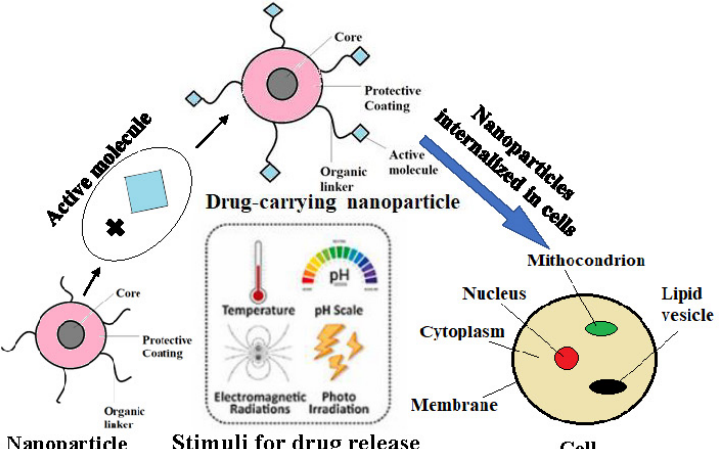
Figure 2. Structure of a magnetic nanoparticle with active molecule on the surface (drug-carrying nanoparticle) and the influential factors on its behavior within a drug delivery system, including stimuli for drug release and cell structure that interact with such nanoparticles.